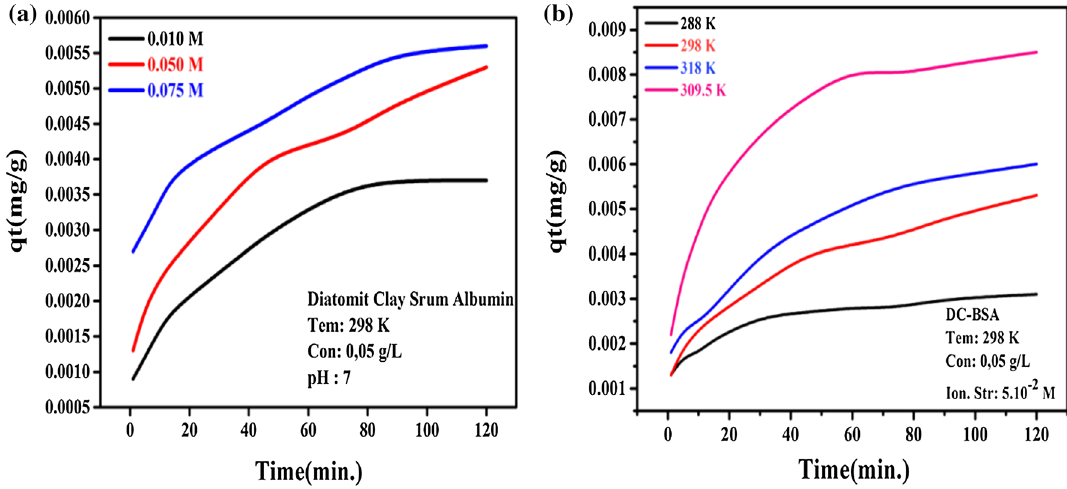
Fig. 2 The effect of a ionic strength and b temperature to the adsorption rate of BSA on diatomite clay